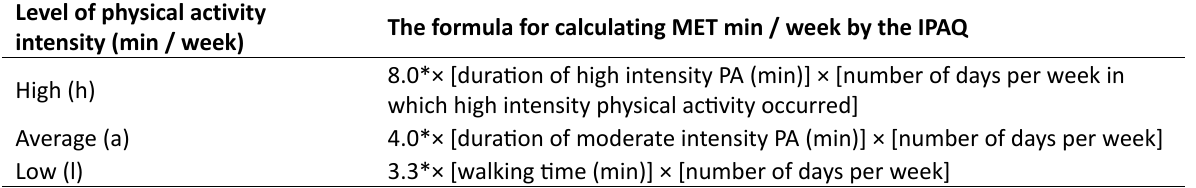
Table 1. The method of determining the level of physical activity intensity by MET (min / week) Level of physical activity intensity (min /